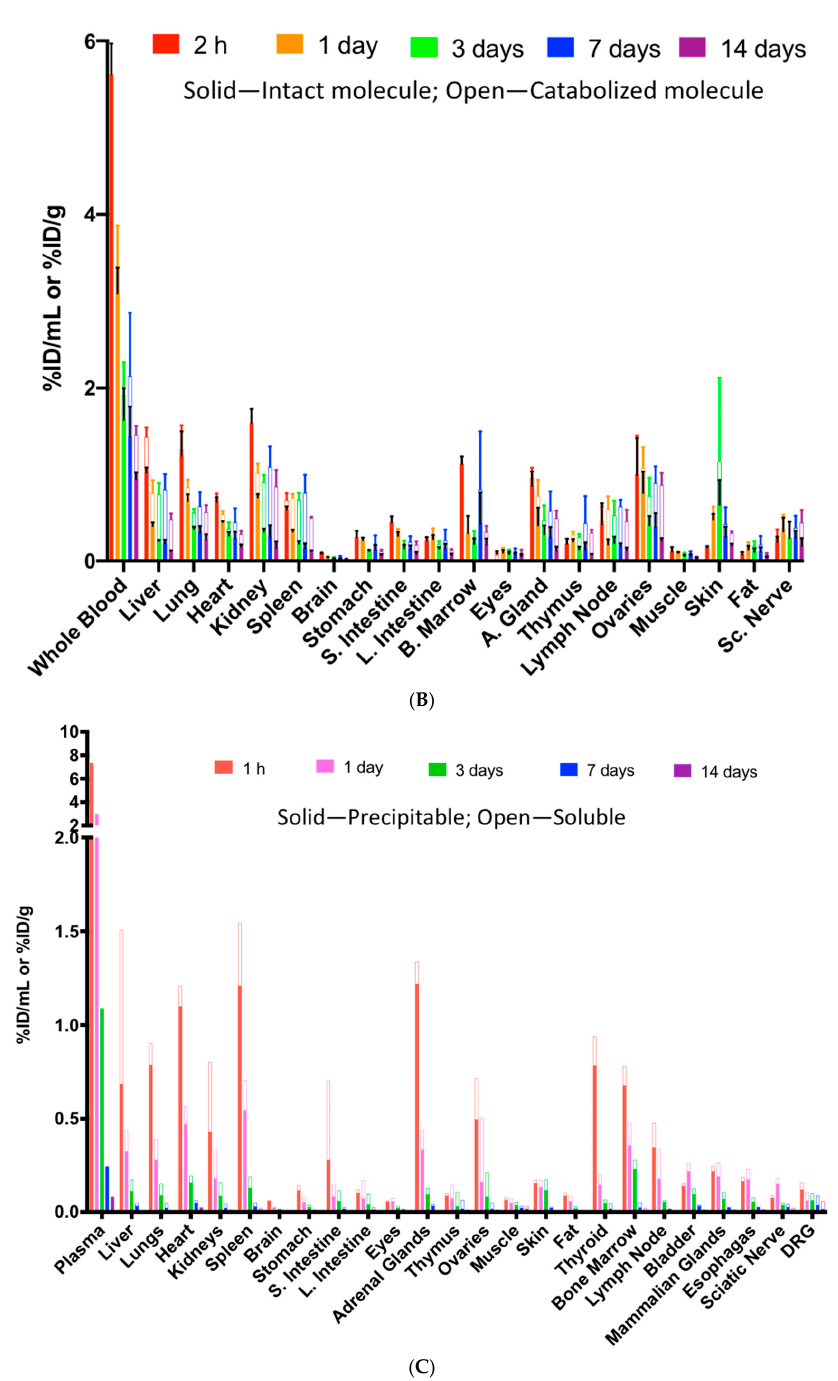
Figure 6. The tissue distribution of radiolabeled polatuzumab vedotin and unconjugated polatuzumab antibody after a single dose via IV administration in rats. ( A ) The tissue and blood radioactivity from intact ( 125 I radioactivity—solid bar) and catabolized